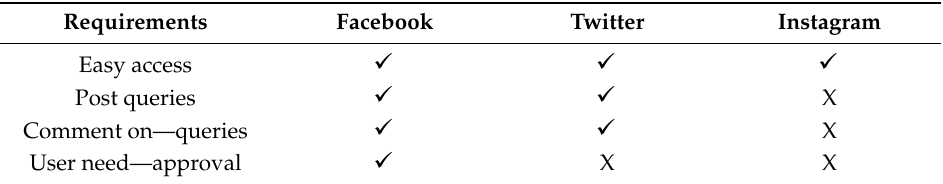
Table 2. Offered features of selected SNS .